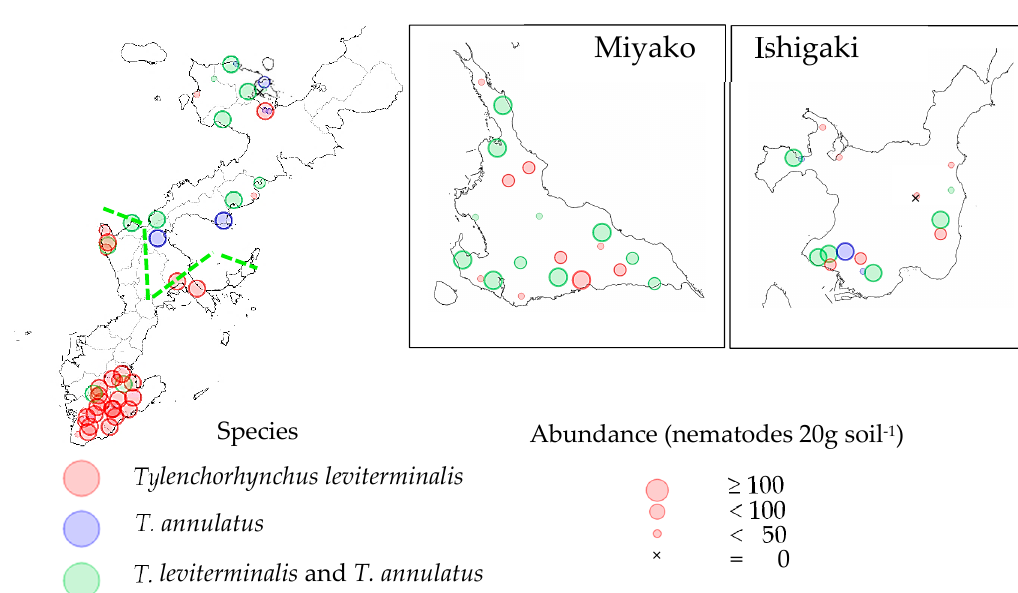
Figure 3. Distribution and abundance of Tylenchorhynchus spp. in Okinawa, Miyako, and Ishigaki. The green dotted line in Okinawa map is to separate North and South. The maps are based on the blank map [21] published by Geospatial Information Authority of Japan [22].